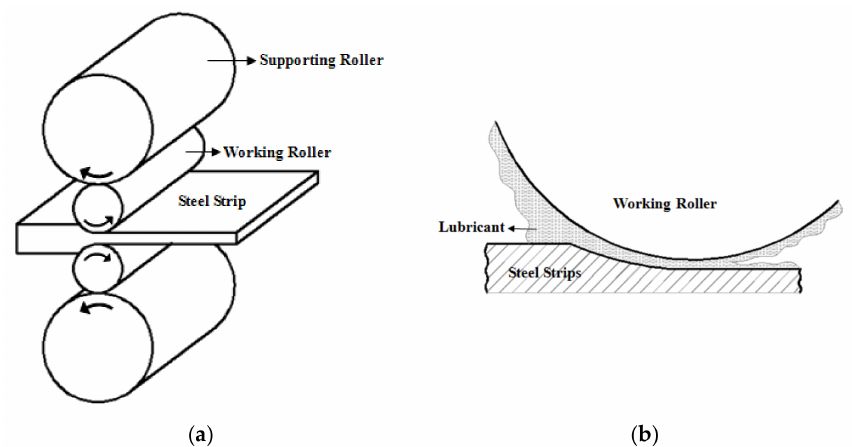
Figure 2. Sketches of ( a ) hot rolling and ( b ) lubrication during hot